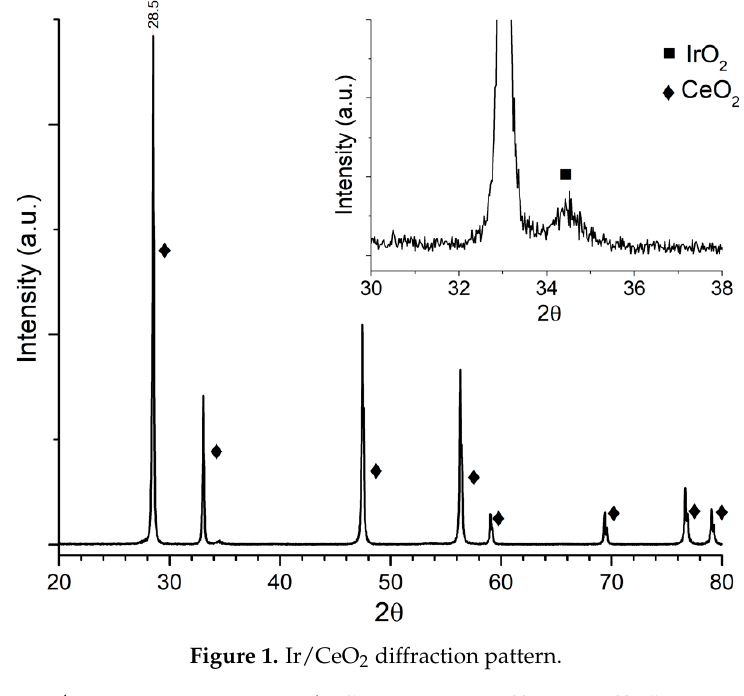
Figure 1. Ir/CeO 2 diffraction pattern.